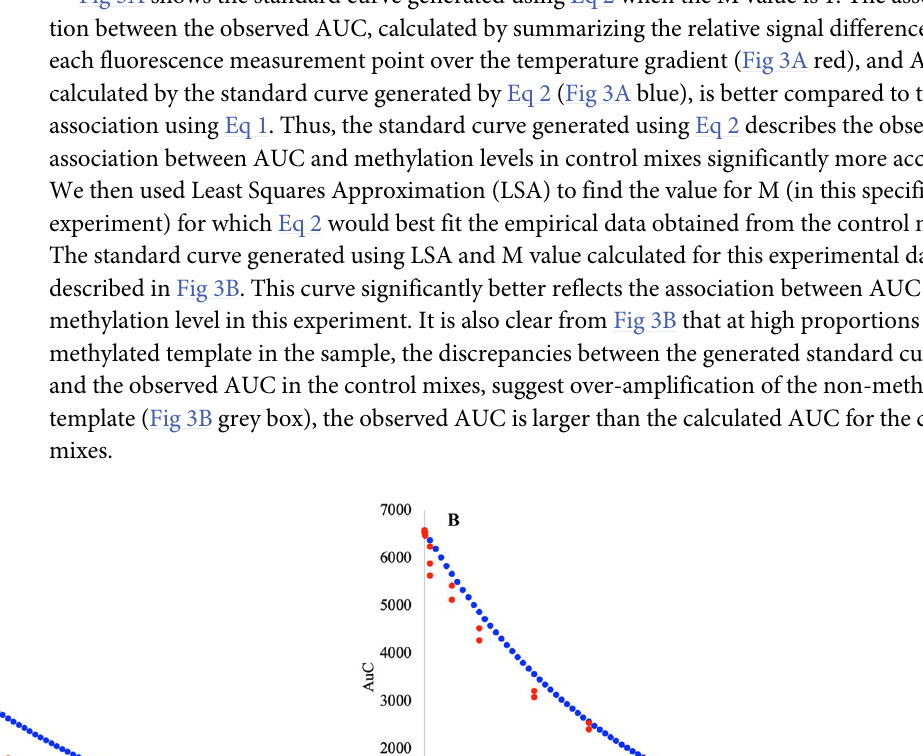
PLOS ONE | https://doi.org/10.1371/journal.pone.0273058 September 6,